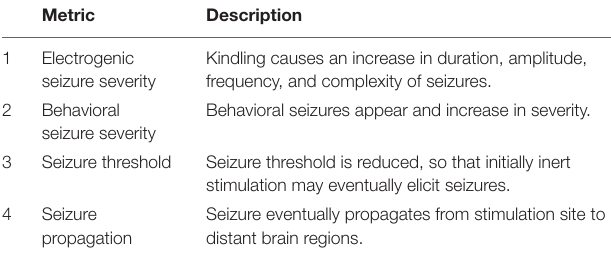
TABLE 2 | Hallmark features of